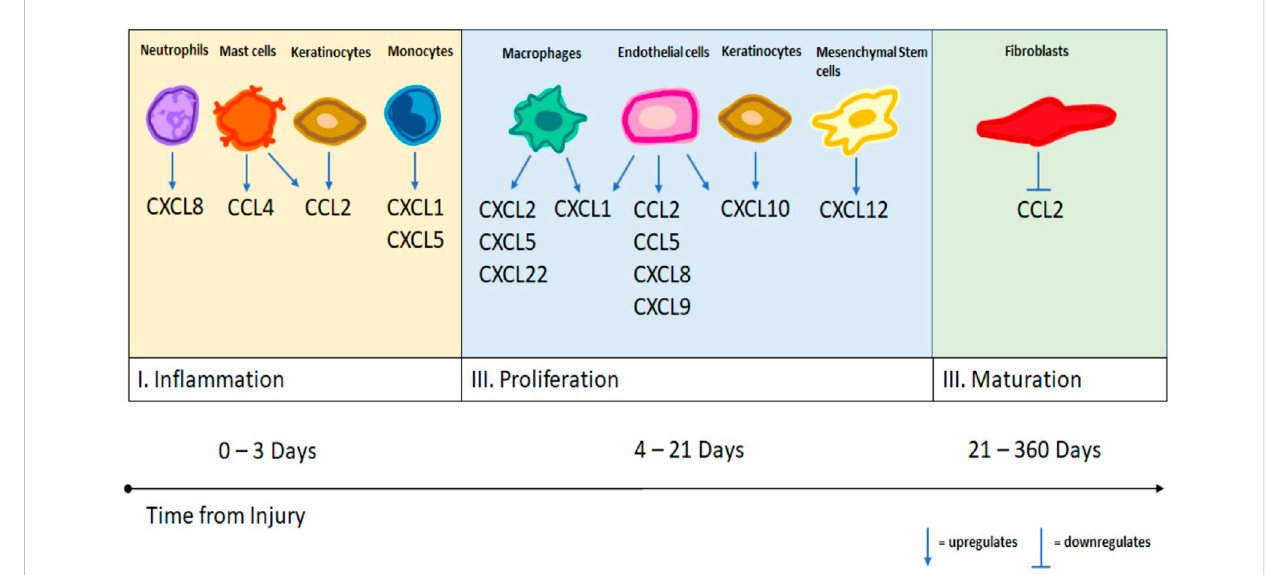
FIGURE 1 A summary of different cell types and their upregulation and downregulation of speci fi c chemokines as demonstrated by the